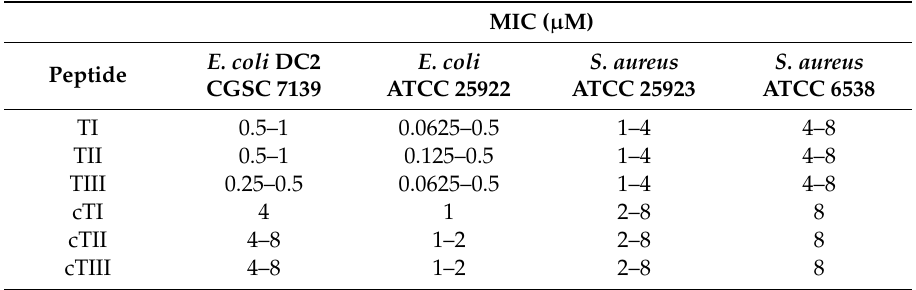
Table 3. The minimal inhibitory concentrations (MICs) of tachyplesin I–III (TI-TIII) and of their cyclic analogues (cTI-cTIII) against planktonic bacteria.